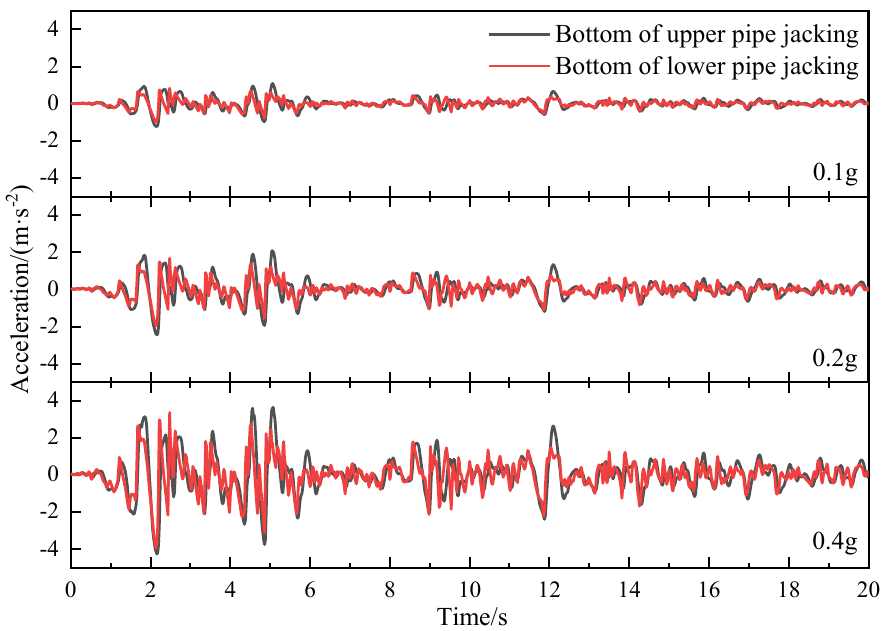
Figure 7. Acceleration time history curves at the bottom of pipe jacking.